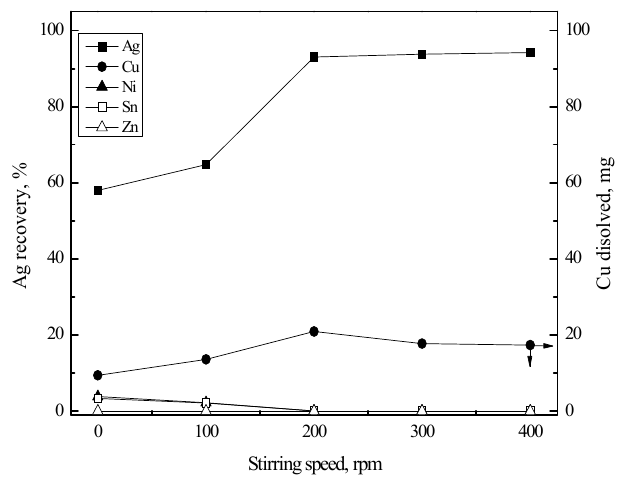
Figure 9. Effect of stirring speed on the Ag recovery by cementation with Cu sheet. Stirring speed = 0–400 rpm; temperature = 80 °C; time = 60 min; copper sheet = 50 × 12.5 mm 2 .